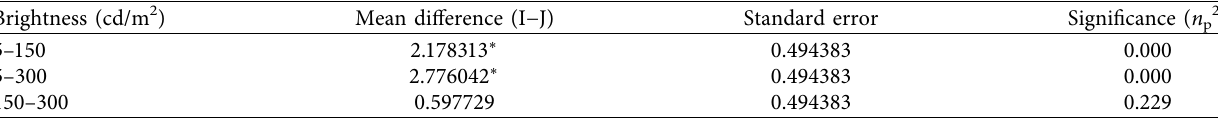
Table 2: Standard error and significance of reaction time between two different brightness